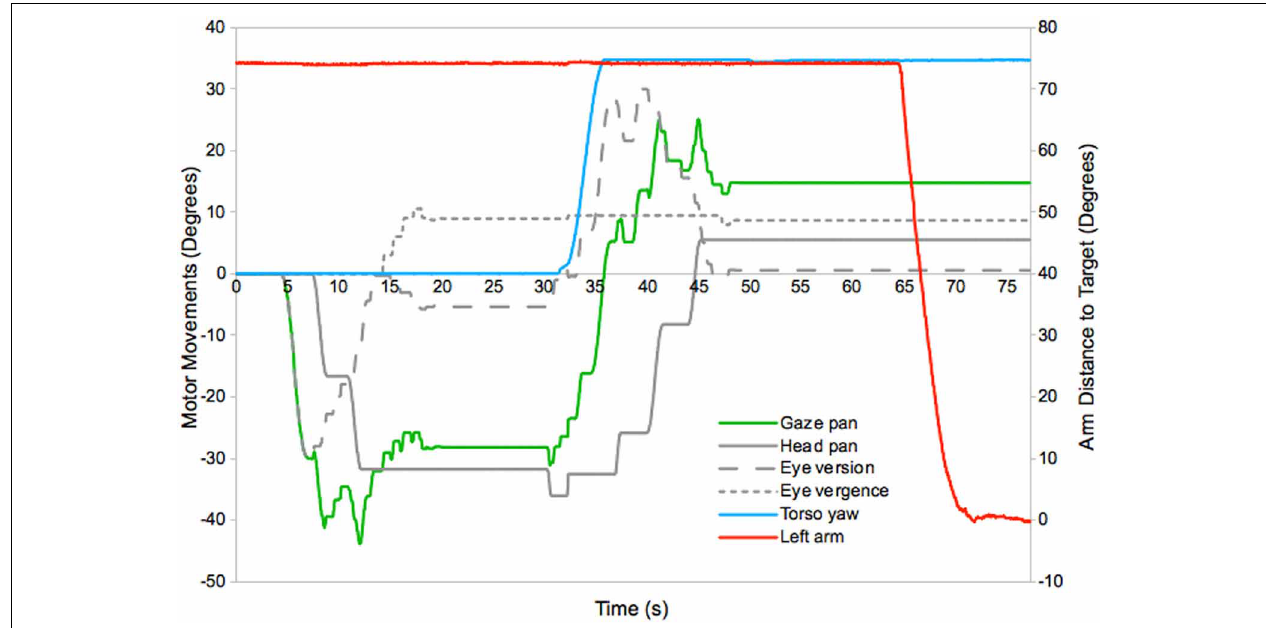
FIGURE 5 | Motor dynamics in the horizontal plane during a typical gaze and reach action (see text for details) 4